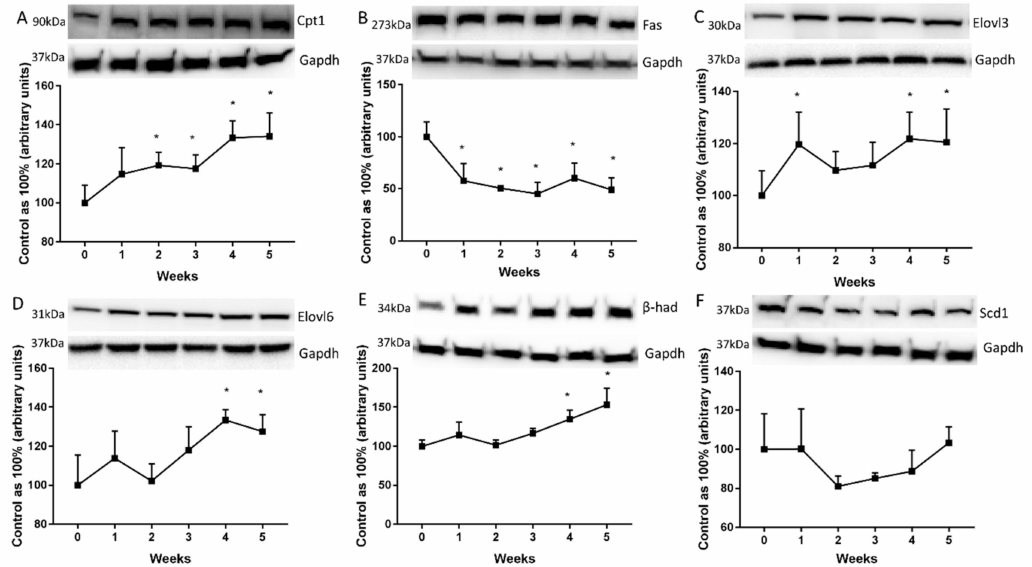
Figure 4. Representative Western blots showing the expression of proteins involved in fatty acids metabolism, i.e. carnitine palmitoyltransferase 1 (Cpt1) ( A ), fatty acid synthase (Fas) ( B ), elongase 3 (Elovl3)( C ),elongase6(Elovl6)( D ),beta-hydroxyacyl-CoAdehydrogenase( β -had)( E )andstearoyl-CoA desaturase 1 (Scd1) ( F ) in the liver homogenates from control group (0 week) and HFD group at the end of each experimental week (1, 2, 3, 4 and 5). The protein expression was measured using Western blot method as it was described in ‘Materials and methods’ section. The data are expressed as the mean ± S.D. and are based on six independent determinations ( n = 6). * p < 0.05 significant di ff erence vs control group (0 week). The samples derived from the same experiment and blots were processed in parallel.